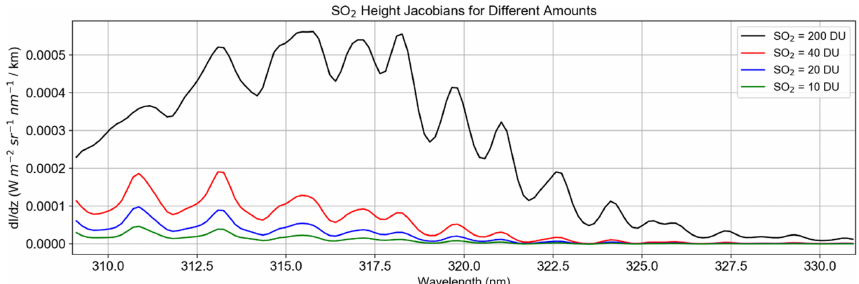
Figure 4. SO 2 Height Jacobians (d I/ d z ) for four different assumed SO 2 column amounts. The Jacobians were calculated from the difference between two radiance spectra with 10 and 20km SO 2 height. All other physical parameters were identical in the calculation of the